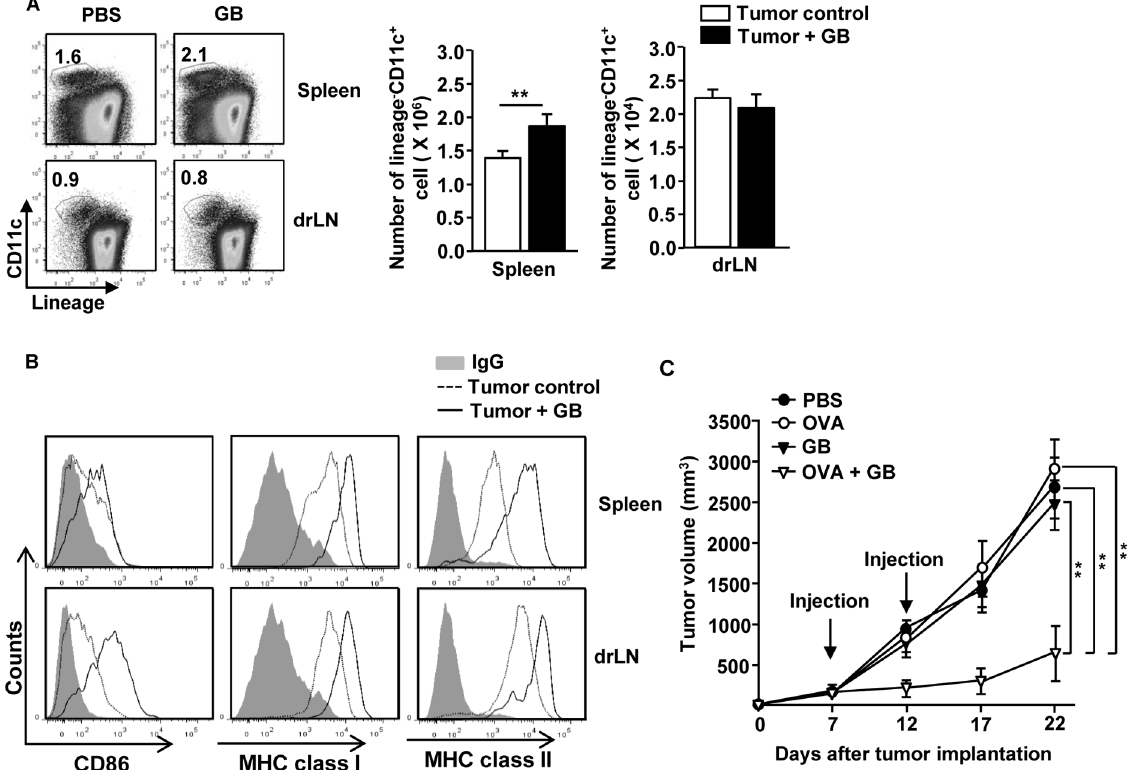
Fig 6. GB promotes anti-cancer activity by DC activation. C57BL/6 mice were injected s . c . with 1 X 10 6 B16 cells. After 15 days, once tumors were well established, mice were treated with GB for 24 hours. (A) Percentage of lineage - CD11c + DCs in spleen and drLN were analyzed on a flow cytometry (left panels). Absolute cell number of DCs in spleen and drLN were shown (right panel). ** p < 0 . 01 . (B) Expression level of CD86, MHC class I and MHC class II in spleen and drLN were measured by flow cytometry. (C) C57BL/6 mice were injected s . c . with 1 X 10 6 B16 cells. Once tumors were well established on day 7, mice were received i . p . with PBS, OVA, GB or the combination of OVA and GB and 5 days later, treated with the same amount of OVA and GB again and tumor growth was measured. All data are representative of or the average of analyses of 6 independent samples (2 mice per experiment, total 3 independent experiments). ** p < 0 . 01